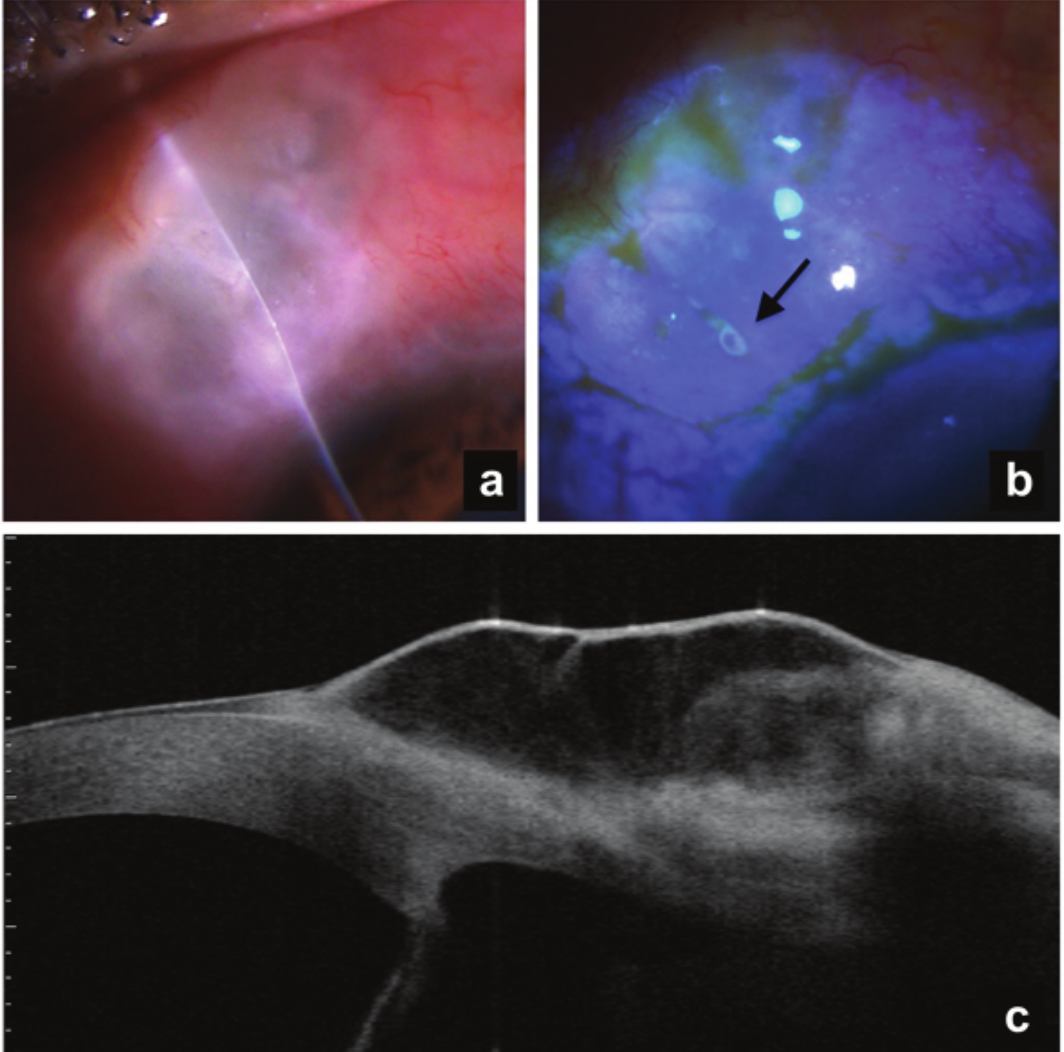
Figure 1. Clinical photograph of the bleb showing (a) a very thin, avascular and, multicystic bleb. (b) fluorescein staining of the bleb showing a pinpoint leak (black arrow). (c) ASOCT image of the